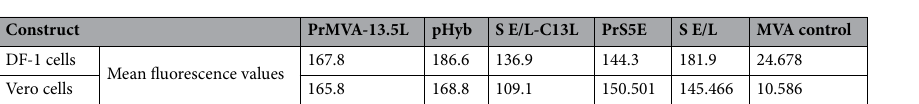
Table 2. Mean of fluorescence particles counted in immunofluorescence images. DF-1 and Vero cells infected with each construct were photographed at 10X objective (70% brightness), and the mean numbers of cells expressing p30 protein were calculated using the ImageJ